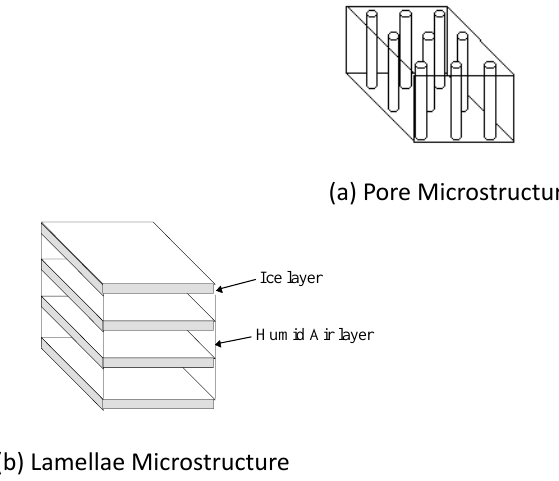
Figure 2. Idealized microstructures used to model heat and mass transfer in parallel (a) and series (b)